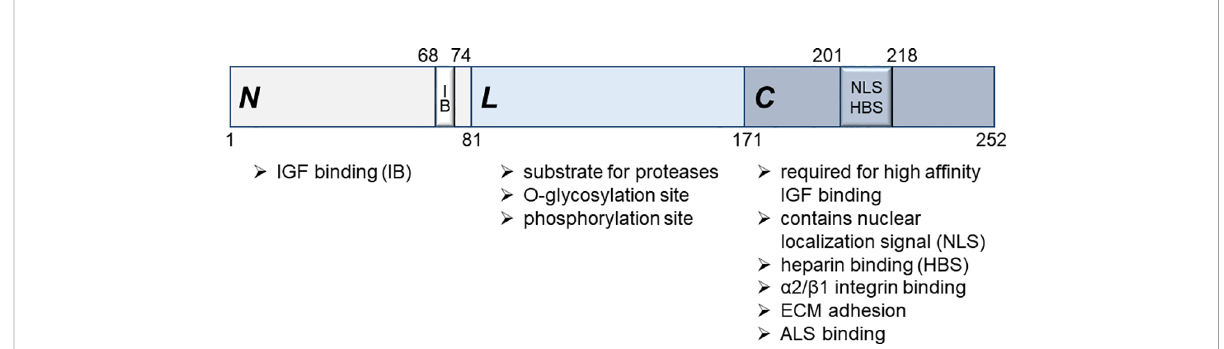
FIGURE 1 Structure of the human mature IGFBP5 protein. Three major domains, the N-terminal (N), the linker (L) and the C-terminal (C) domain, can be distinguished, which ful fi ll different functions as indicated. For high af fi nity IGF binding, the C-terminal domain is required in addition to the primary IGF binding site (IB) within the N-terminal domain between aa 68 and 74. A nuclear localization signal (NLS) is located within the C- terminal domain between aa 201 and 218, which also mediates binding of the IGFBP5 protein to